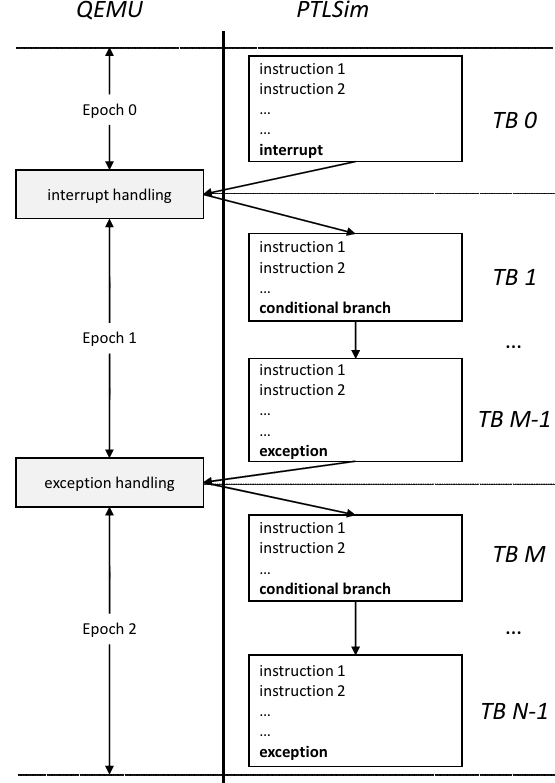
Figure 4. Epochs and simulation flow in the MARSSx86 simulator [33].